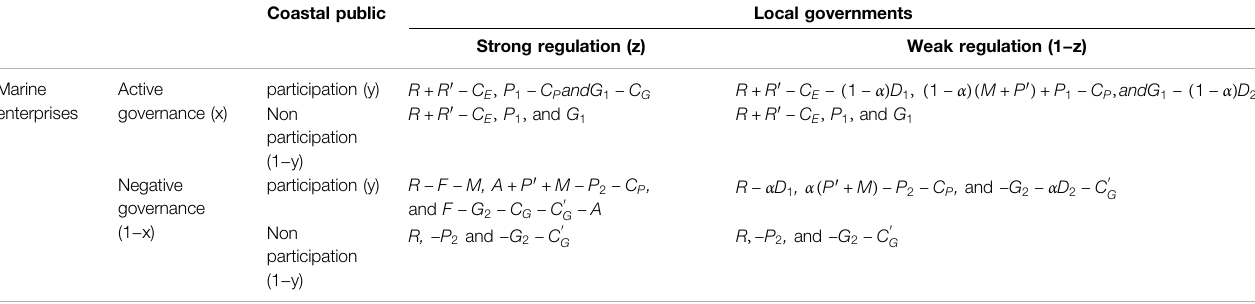
TABLE 2 | Game payment matrix of the three parties. Coastal public Local